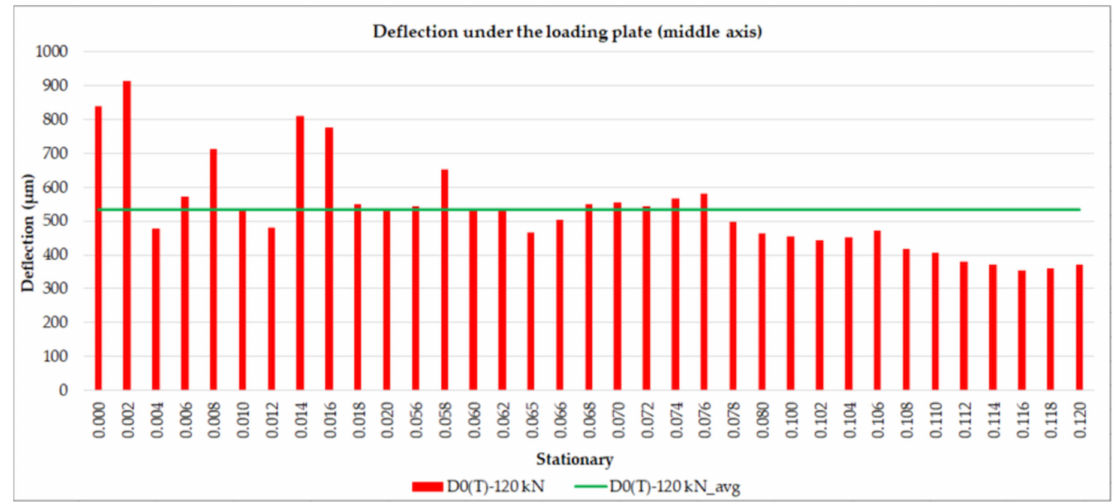
Figure 16. Temperature-corrected deflections D0(T) under the loading plate measured in the middle axis. A demanded ground load capacity was prescribed for each airport, which is expressed by the Californian Bearing Ratio (CBR). The CBR index is determined according to deflections measured under the loading plate. Edvard Rusjan Airport in Maribor has the prescribed minimal value of CBR pavement—15% of Pavement Classification Number (PCN) 86. The average value of the CBR index in the middle axis amounted to 30%, which satisfied the required